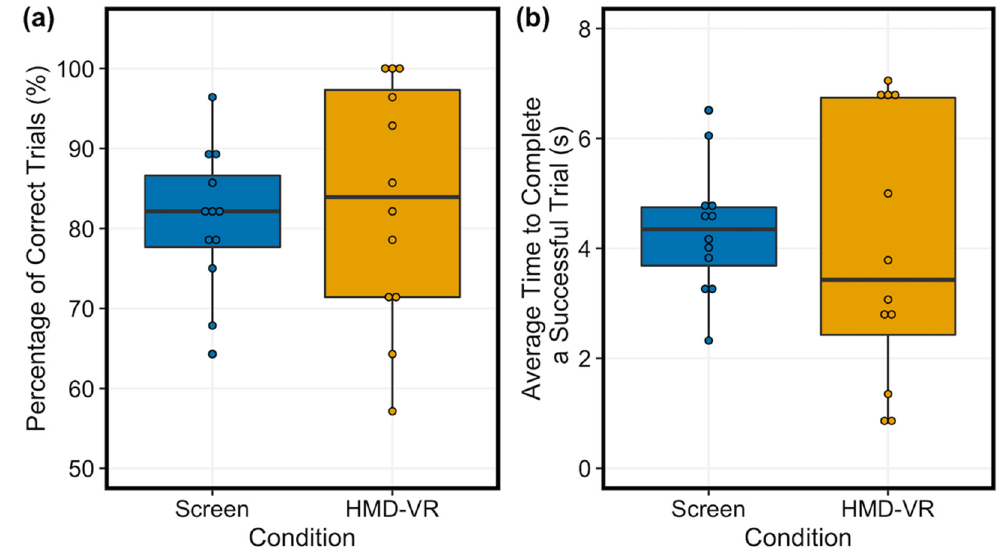
Figure 4. Average performance on trials and time to complete successful trials between conditions. (a) The analysis showed no significant differences in performance between Screen (left, blue) and HMD-VR (right, yellow) conditions. (b) The analysis showed no significant differences in time on successful trials between Screen (left, blue) and HMD-VR (right, yellow) conditions.